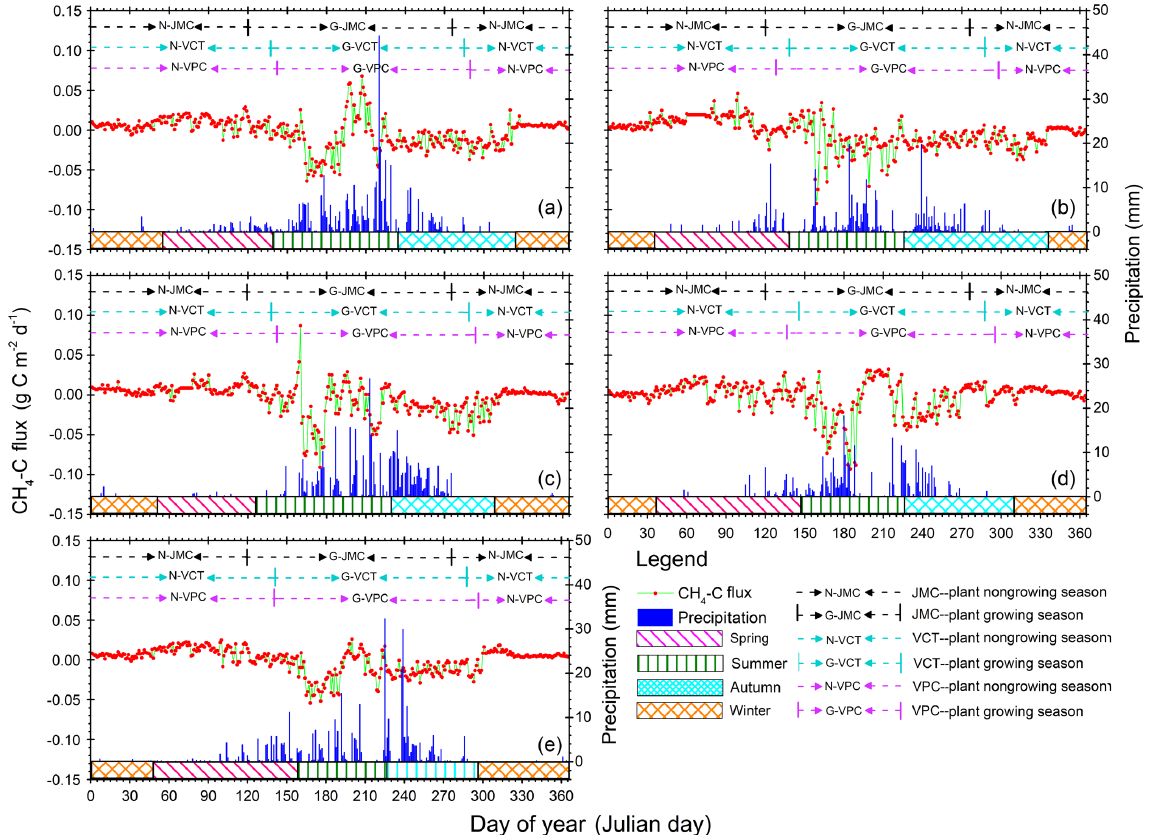
Figure 3. Annual patterns of diel methane (CH 4 ) flux and precipitation variations from 2012 to 2016. Positive values indicate CH 4 release and negative values indicate CH 4 uptake by ecosystems. Red dots and light green lines are CH 4 -C flux variation, and the deep blue histograms show diel precipitation accumulation. Pink, olive, cyan, and orange blocks mean spring, summer, autumn, and winter seasons, respectively, according to our new method of SMT (see Sect. 2). Black, cyan, and pink dotted lines with bars separated the plant growing from nongrowing seasons and stand for seasons with the JMC, VCT, and VPC methods, respectively. Details about the JMC, VCT, and VPC methods can be found in Sect.